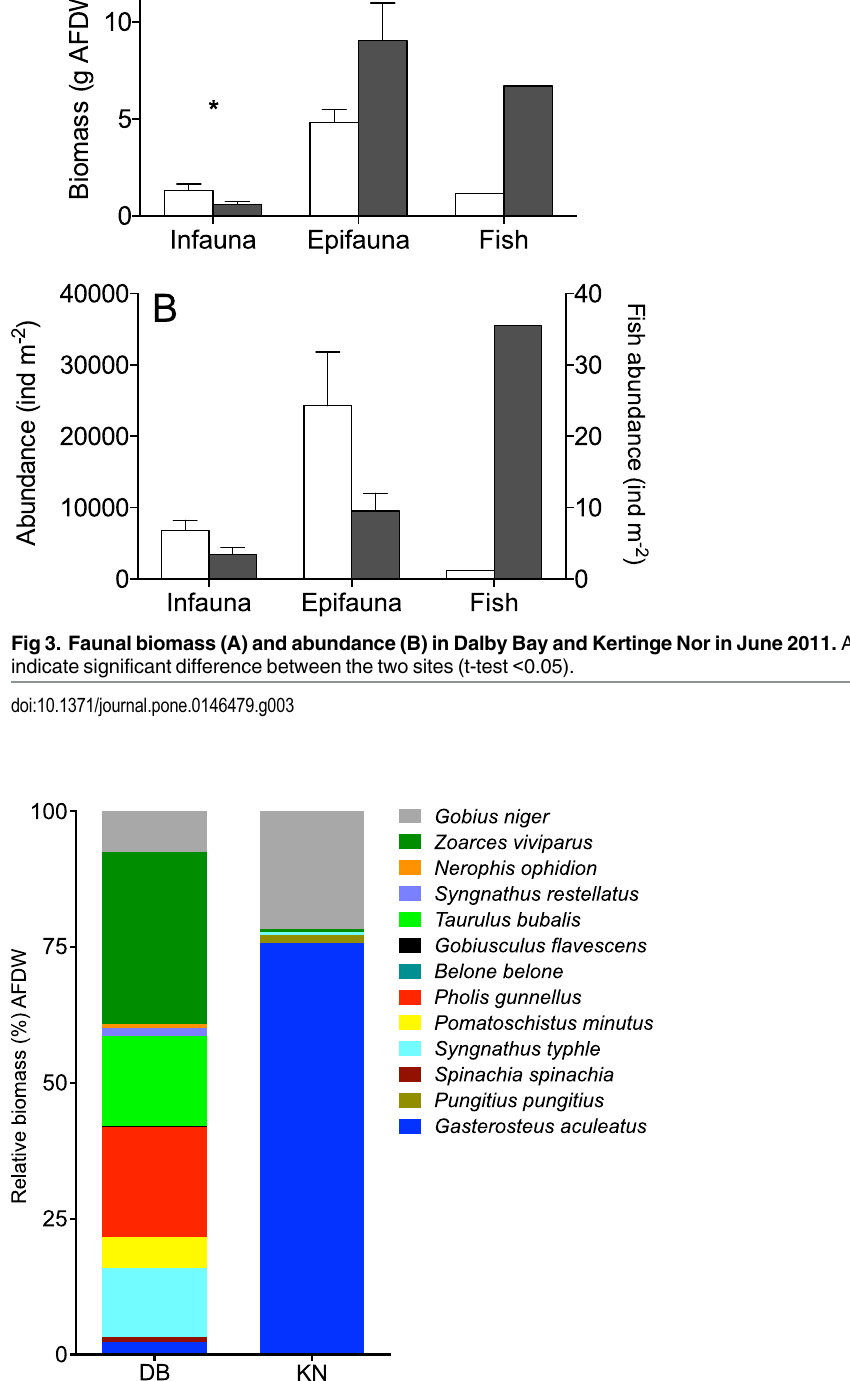
Fig 4. The relative (%) species contribution to total fish biomass (AFDW m -2 ) in Dalby Bay (DB) and Kertinge Nor (KN) in June